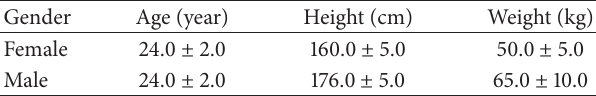
Table 1: Subjects characteristics (mean ±